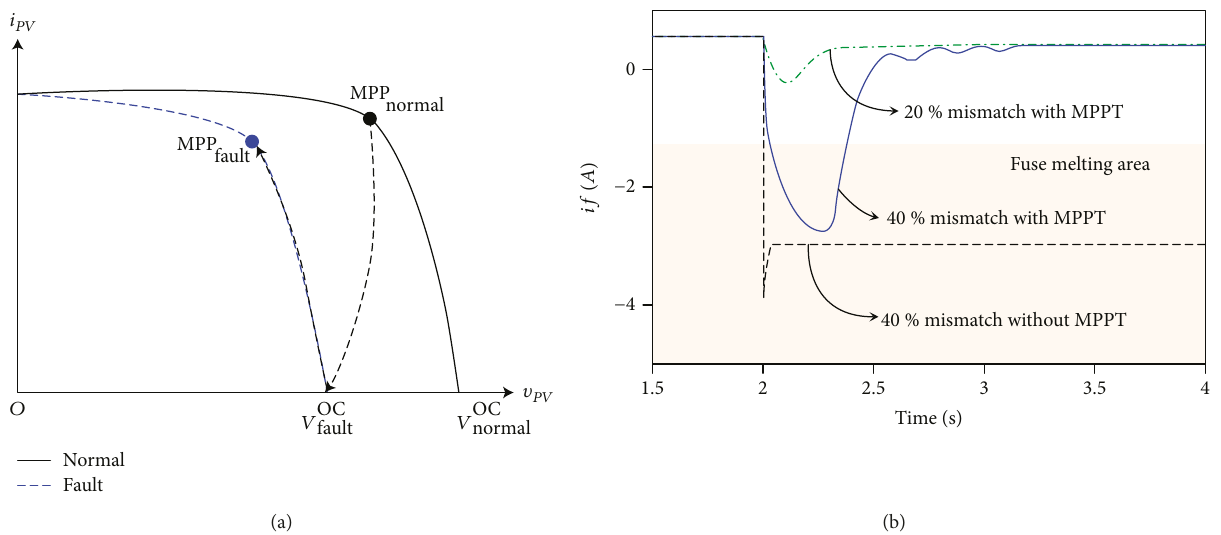
Figure 7: (a) Change of operating point due to the interaction between fault and MPPT algorithm. (b) Back-feeding current of a faulted PV string (LLF occurs at t = 2s